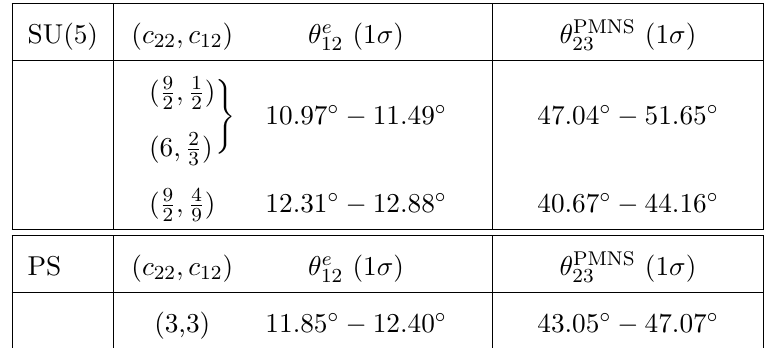
, together with Table 3 . SU(5) and PS Clebsch factor combinations with predicted ranges of θ e 12 their respective predictions for θ PMNS . As mentioned in the main text, the Clebsch combinations 23 ( 9 / 2 , 1 / 2) and ( 6 , 2 / 3 ) give the same prediction for θ PMNS 23